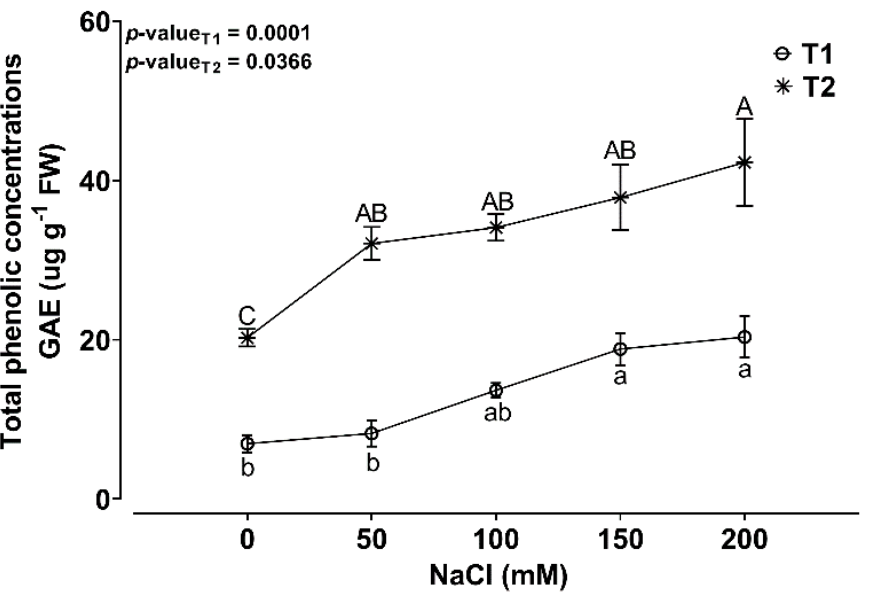
Figure 4. Total phenolic concentration in red lettuce plants ( Lactuca sativa Lollo Rosso cv. ‘CARMOLI’) growing at different saline concentrations in a hydroponic system. T1: total phenols after 7 days of NaCl application. T2: total phenols after 15 days of NaCl application. GAE: gallic acids equivalents. Different letters indicate significant differences ( p < 0.05), according to the Tukey multiple range test ( p < 0.05) following ANOVA. Data are expressed as mean ± SE, n = 6.